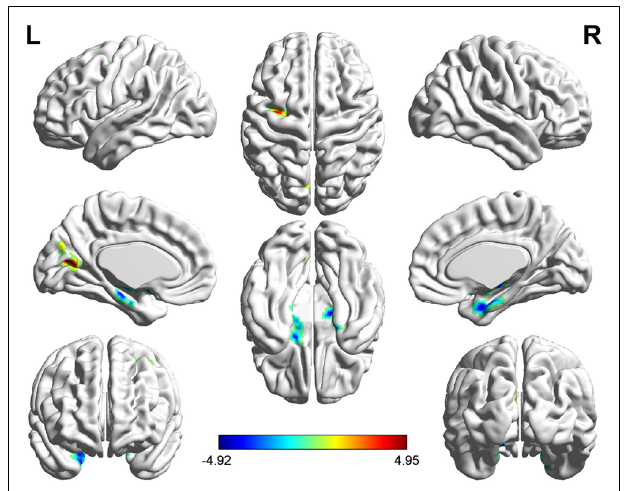
FIGURE 1 | Significantly increased (red) and decreased (blue) amplitude of low-frequency fluctuation (ALFF) values in patients with active-stage ulcerative colitis (UC) compared with healthy controls [HCs; peak level threshold p = 0.001, cluster level false discovery rate (FDR)-corrected p < 0.05]. The color bar represents the t -value of the two-sample t -test between the two groups.